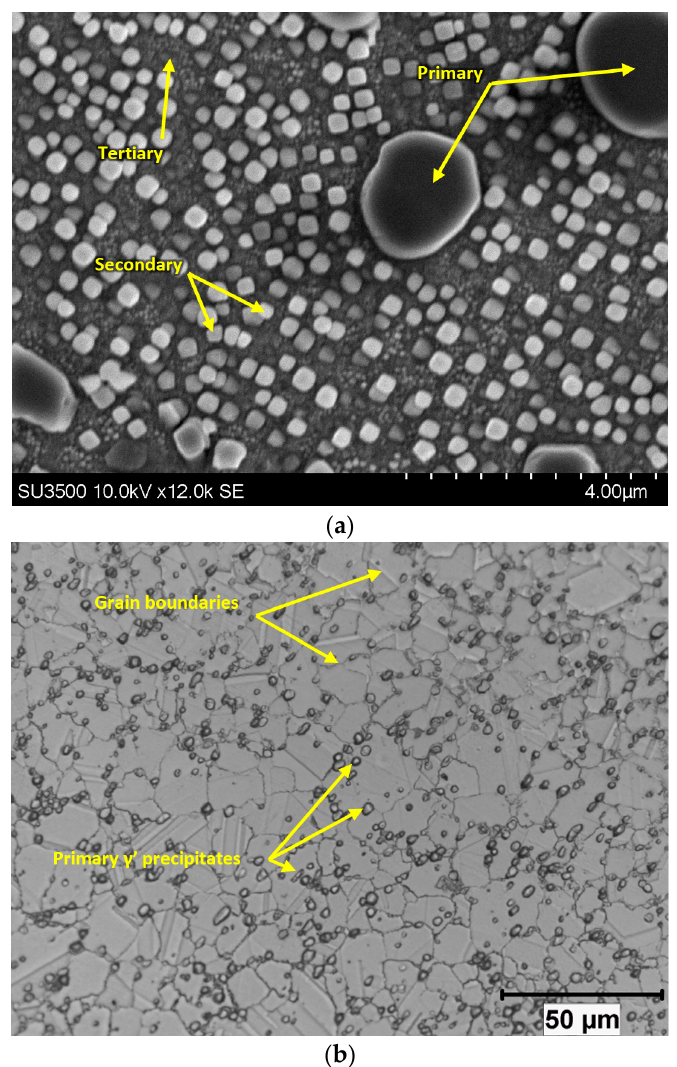
Figure3. MicrostructuresofRene65( a )Scanningelectronmicroscopy(SEM)imageshowingtheprimary, Figure 3. Microstructures of Rene 65 ( a ) Scanning electron microscopy (SEM) image showing the secondary and tertiary γ (cid:48) precipitates, ( b ) Optical image of γ (cid:48) precipitates along grain primary, secondary and tertiary γ ’ precipitates, ( b ) Optical image of γ ’ precipitates along grain boundaries.